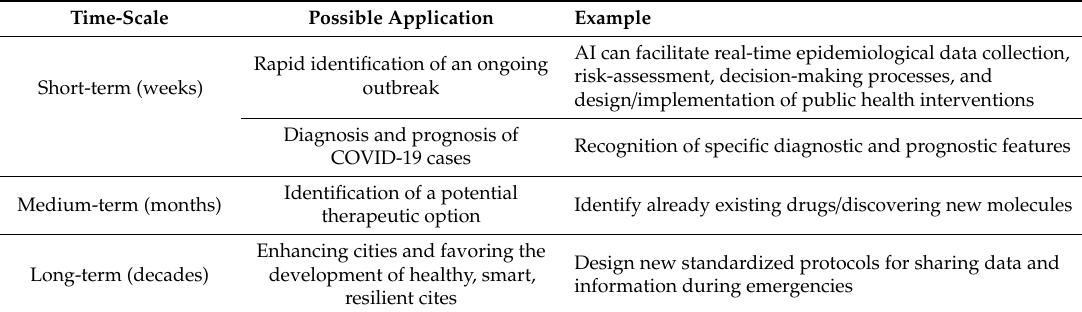
Table 1. Possible applications of Artificial Intelligence and Big Data for the management of the ongoing COVID-19